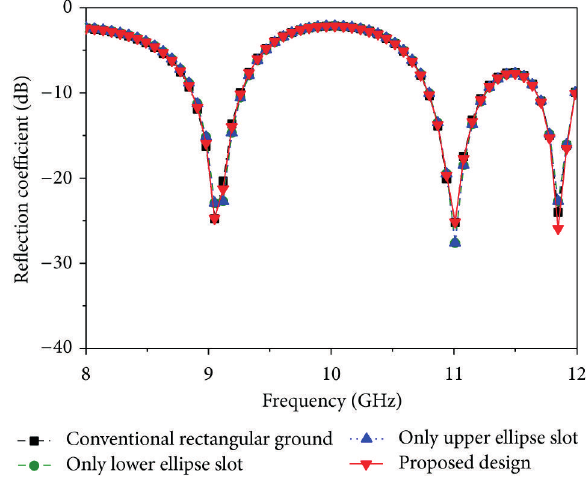
Figure 7: Simulated reflection coefficient for the effect of ground plane modification (other parameters: 𝐿 = 20 mm, 𝑊 = 17.2 mm, 𝐿1 = 3 mm, 𝐿2 = 13 mm, 𝐿 = 17.2 mm, 𝑅1 = 2 mm, 𝑅2 = 3 mm, 𝑋 𝑊 𝑔